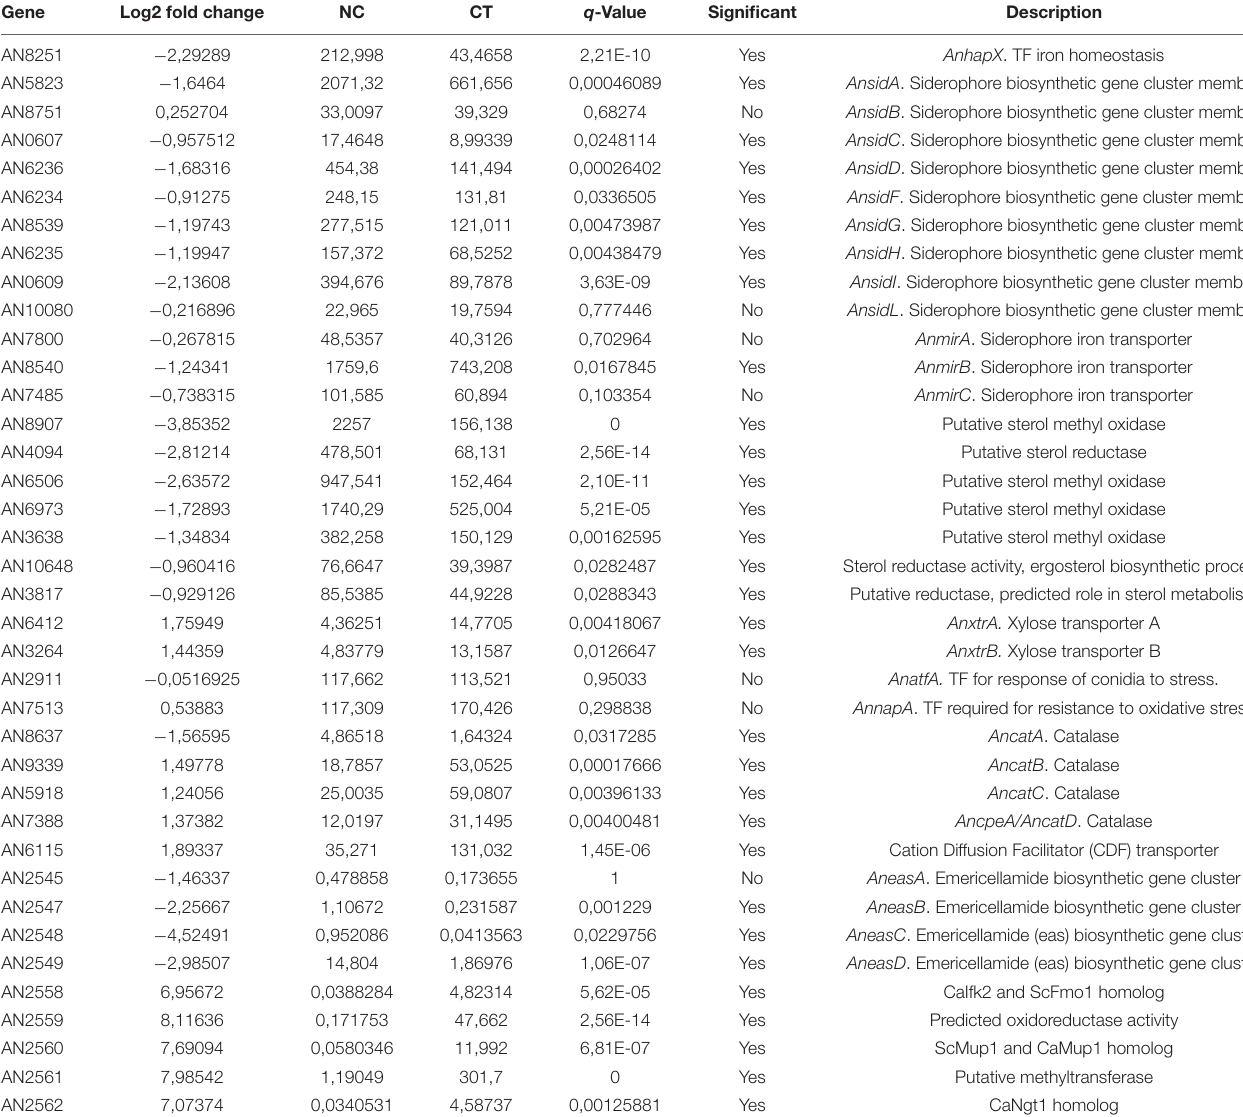
TABLE 2 | RNA-seq data of differentially expressed